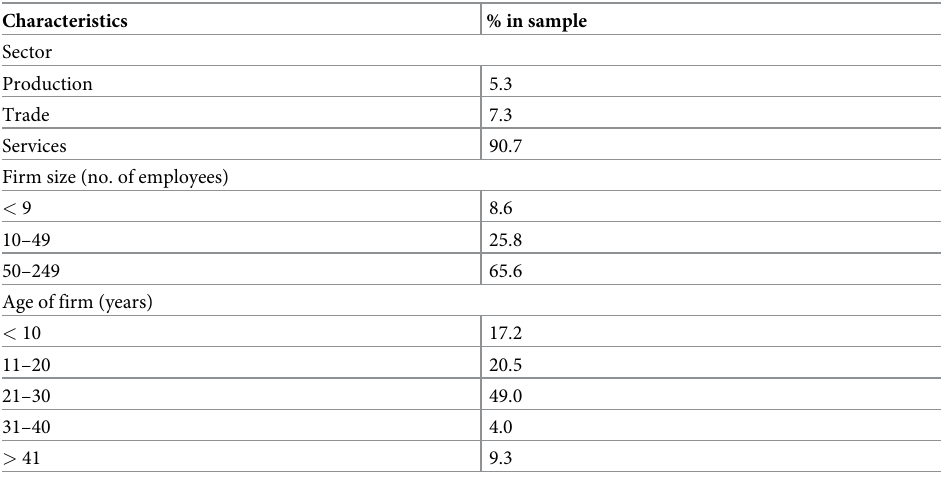
Table 2. The structure of the